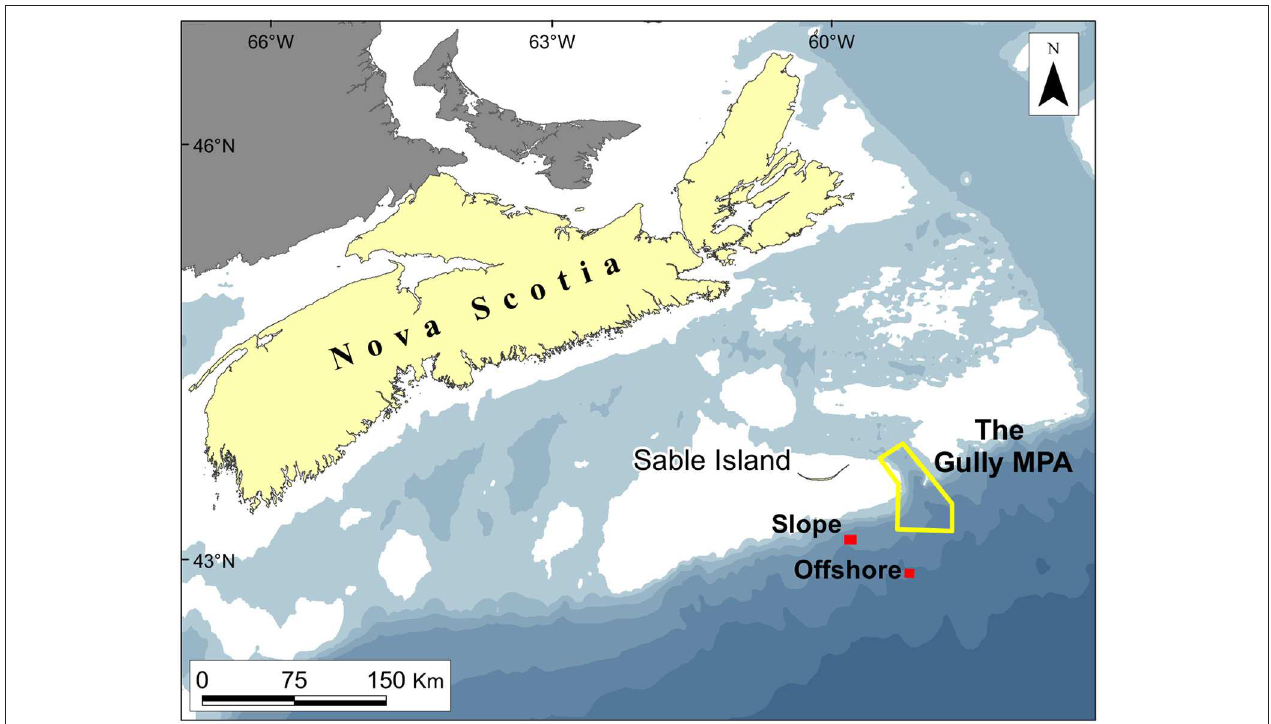
FIGURE 1 | Location of The Gully and The Trough, showing the Offshore and Slope trawling stations: White areas are shallower than 100m, while those shaded in the lightest blue are 100–200m deep.